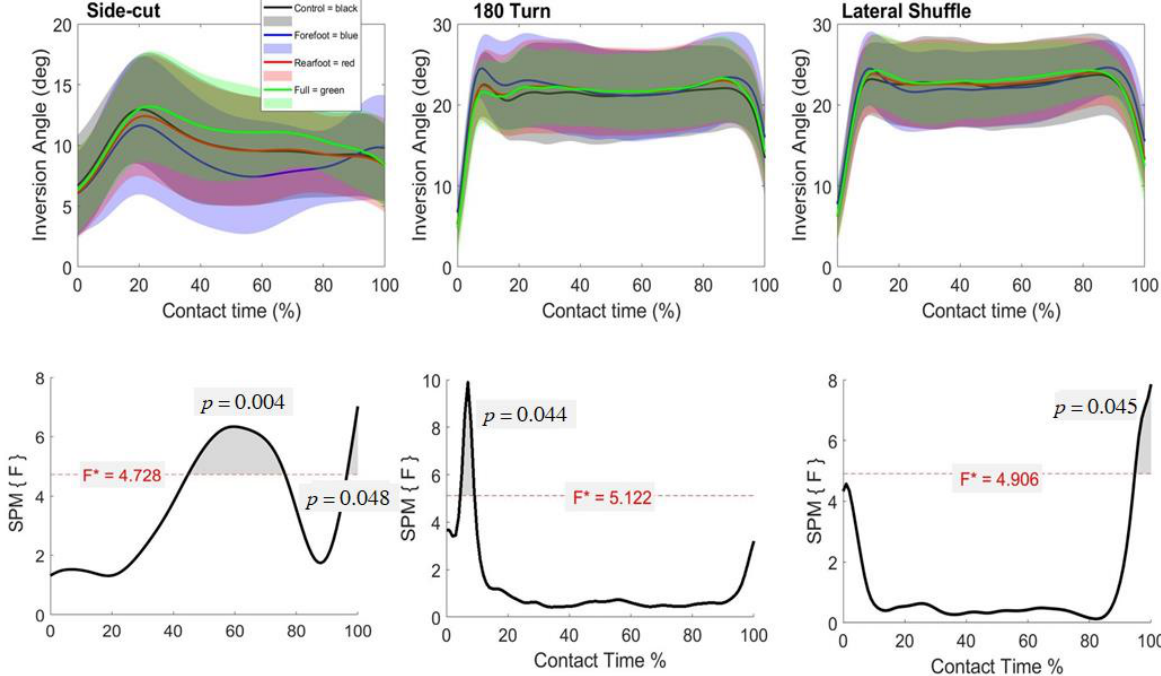
Figure 5. Mean (SD) frontal ankle angle across participants for each shoe condition (Black = Control, Blue = Forefoot, Red = Rearfoot; Green = Full) ( top ). The SPM(F) values across ground contact time ( bottom ). F* = critical value